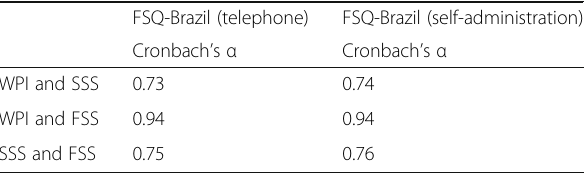
Table 1 Internal consistency of Fibromyalgia Survey Questionnaire (Brazil): telephone interview and self- administration